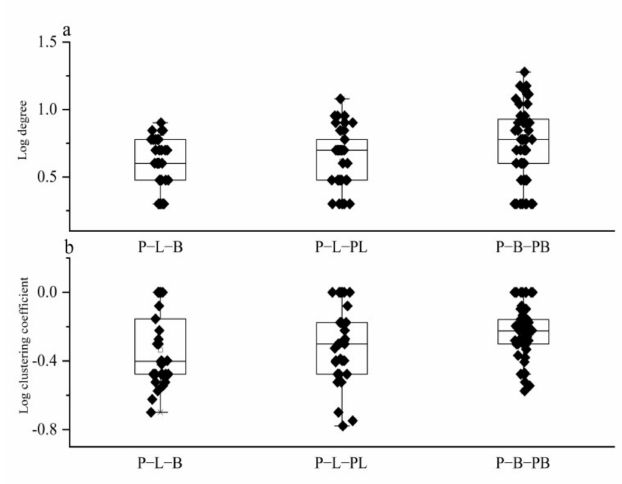
Figure 7. Node connectedness and complexity of microbial networks. ( a ), degree; ( b ), log clustering coefficient. Each box represents the interquartile range, the line in each box represents the median, top and bottom of the boxes represent first and third quartiles, and whiskers represent the range of 1.5 interquartile range. Dots represent single observations.